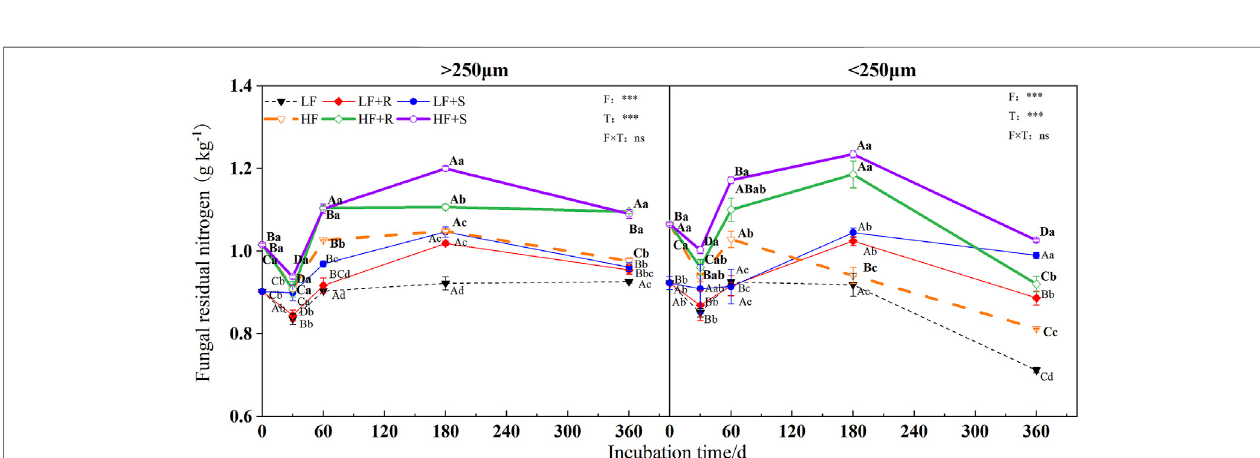
FIGURE 4 | Fungal residual nitrogen in soil aggregates with different soil fertility levels after the addition of different parts of maize residues. Note: LF means low fertility,LF+Rmeanslowfertility+roots,andLF+Smeanslowfertility+Shoots;HFmeanshighfertility,HF+Rmeanshighfertility+roots,andHF+Smeanshighfertility + Shoots. Uppercase letters represent differences between different periods in the same treatment, and lowercase letters represent differences between different treatments at the same period. For the ANOVA, F means fertility level, T means the type of maize residues, and F × T means fertility level × type of maize residues. *,**, and *** mean p < 0.05, 0.01, and 0.001, respectively. ns means no signi fi